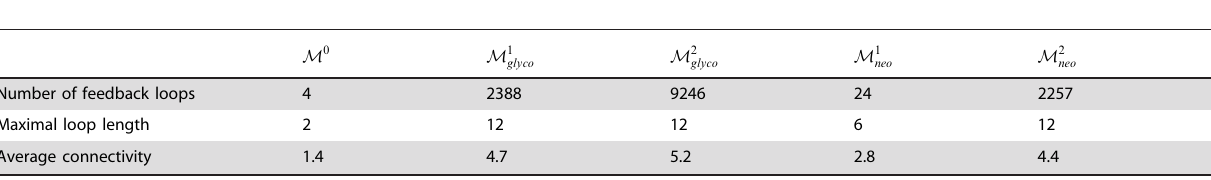
M 0 M 1 glyco M 2 glyco M 1 neo M 2 neo Number of feedback loops 4 2388 9246 24 2257 Maximal loop length 2 12 12 12 Average connectivity 1.4 M 0 corresponds to the transcriptional regulatory network in which indirect interactions mediated by metabolism are not taken into account.